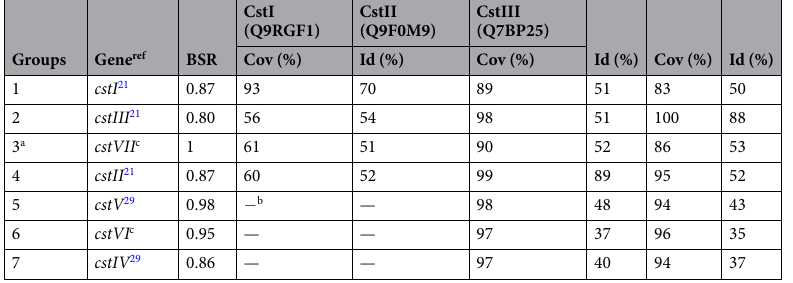
Table 1. Average Blastp Score Ratio (BSR) of the C. coli GT-42 homologs. a Singleton. b No significant hits. c Gene name proposed in this